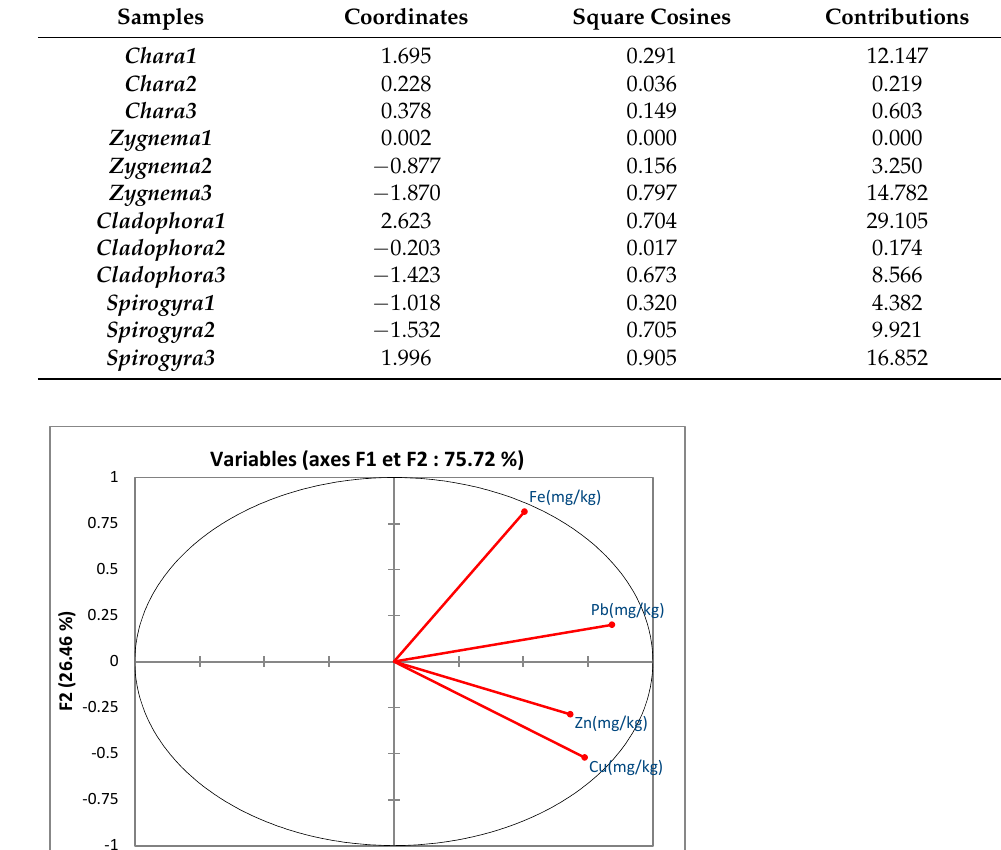
Figure 7. F1xF2 factorial design of variables.